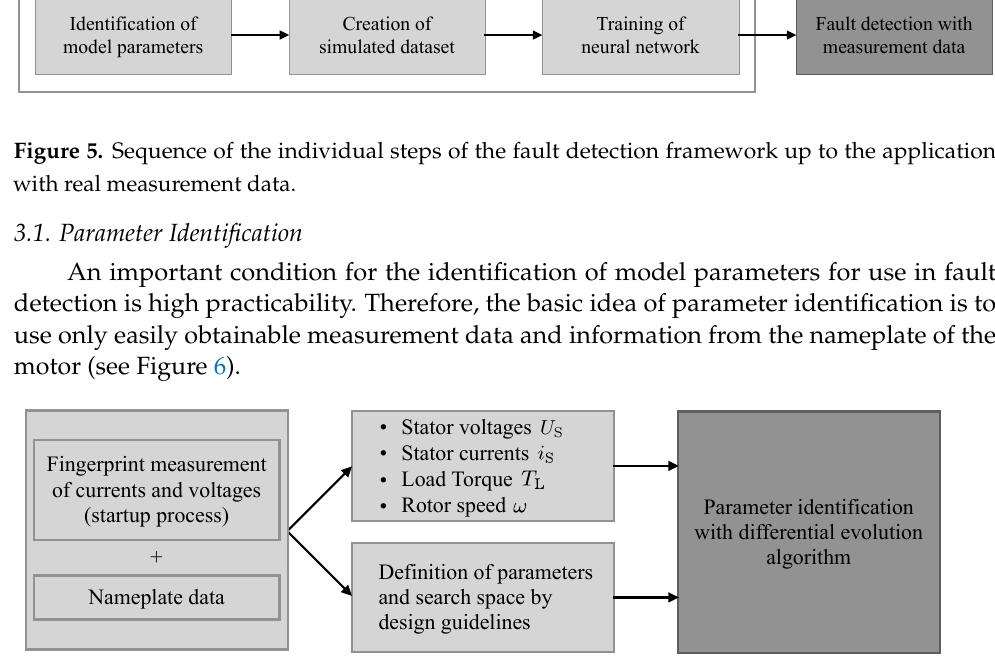
Figure 6. Sequence of the individual steps of the parameter identification from the fingerprint measure- ment (startup process from standstill to rated operation) and nameplate data to the identification